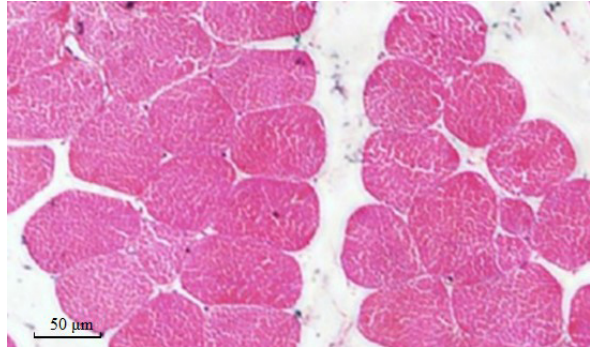
Figure 5. Paraffin section of leg muscle in 10-week-old geese. Muscle fibers were cross-cut. The section was formalin-fixed, paraffin-embedded and counterstained with Mayer’s hematoxylin. In the section, red denotes single muscle fibers and white denotes in-muscle fat. Magnification: